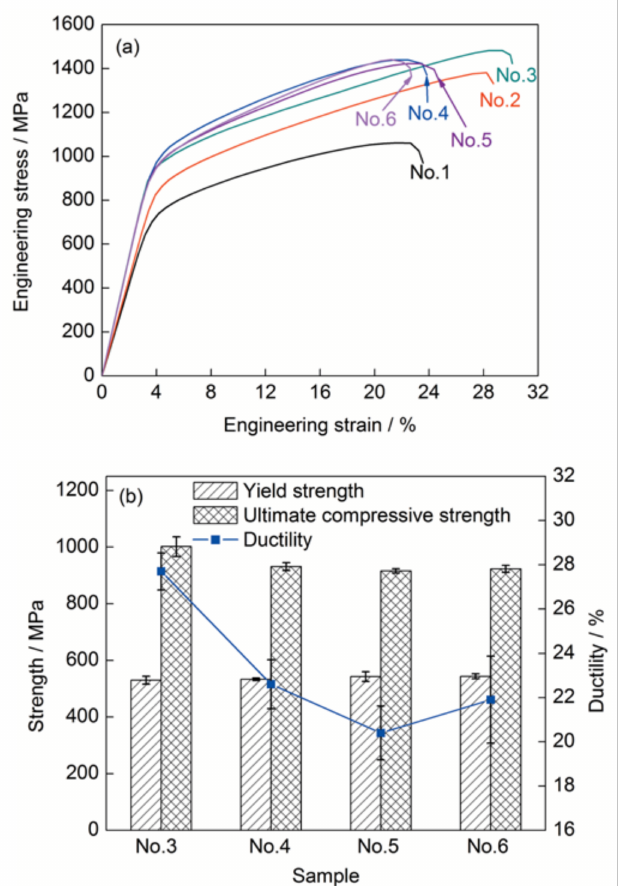
Figure 27. Compression mechanical properties of TA15 titanium alloys prepared by spark plasma sintering at different temperatures (No.3: 900 ◦ C; No.4: 1000 ◦ C; No.5: 1100 ◦ C; and No.6: 1200 ◦ C), measured at ( a ) room temperature and ( b ) 500 ◦ C. Reprinted with permission from ref. [40]. Copyright 2021 Acta Metallurgica